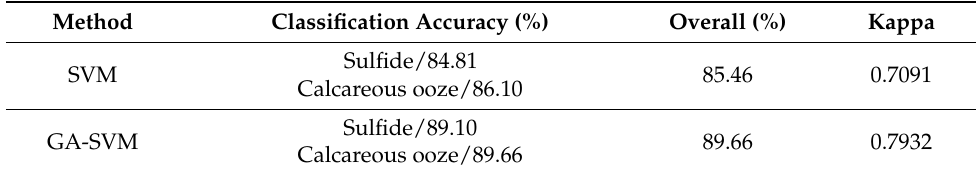
Table 3. Classification accuracy of SVM and GA-SVM.